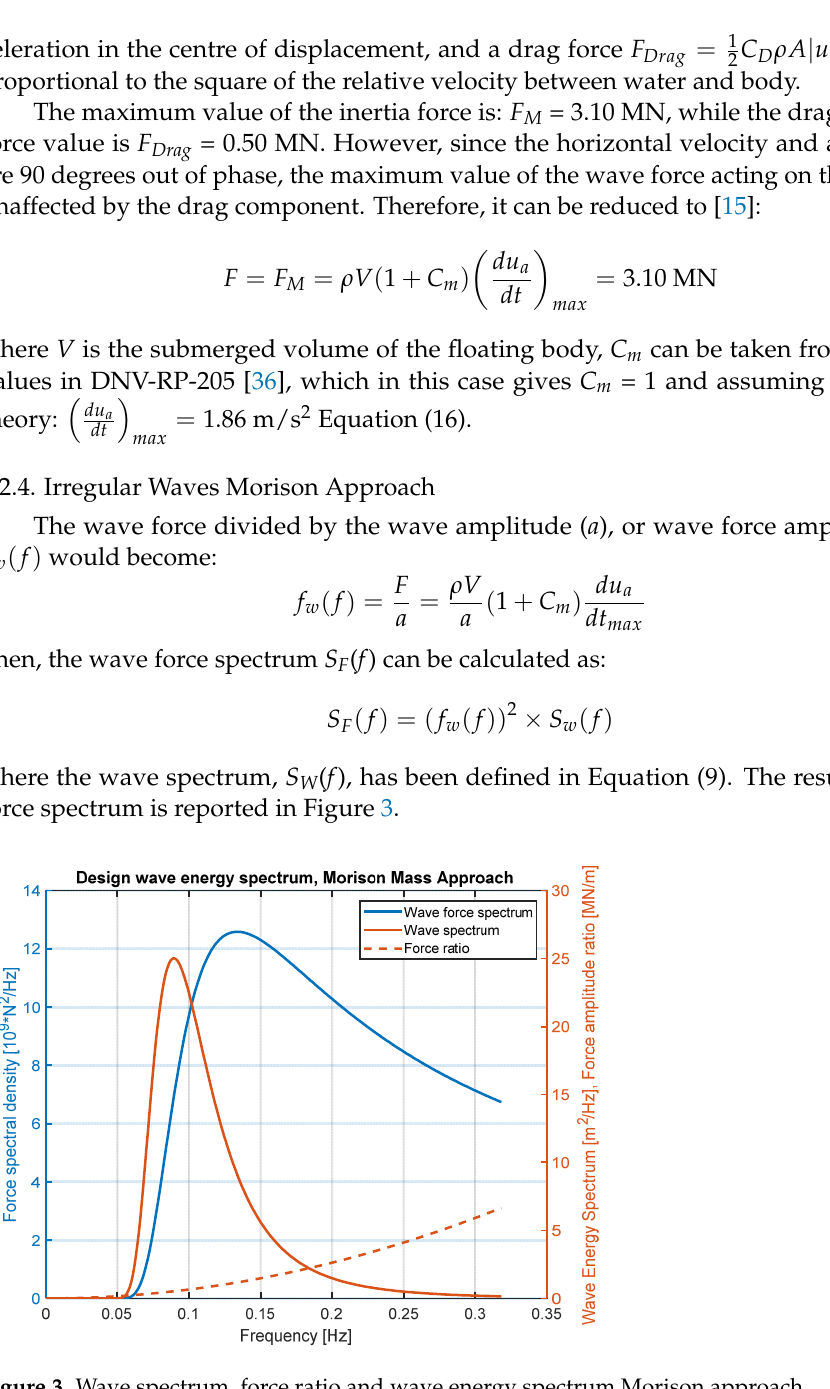
Figure 3. Wave spectrum, force ratio and wave energy spectrum Morison approach.